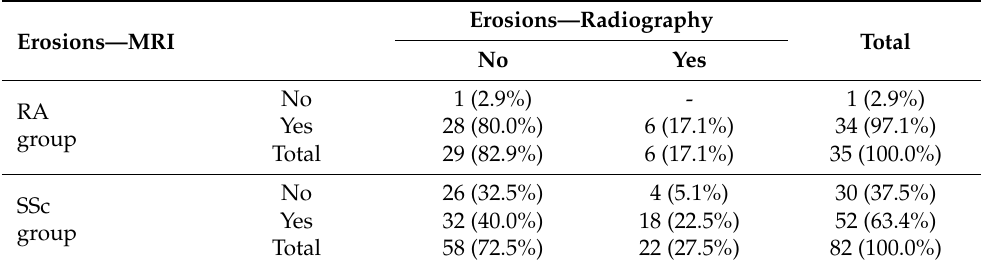
Erosions—Radiography